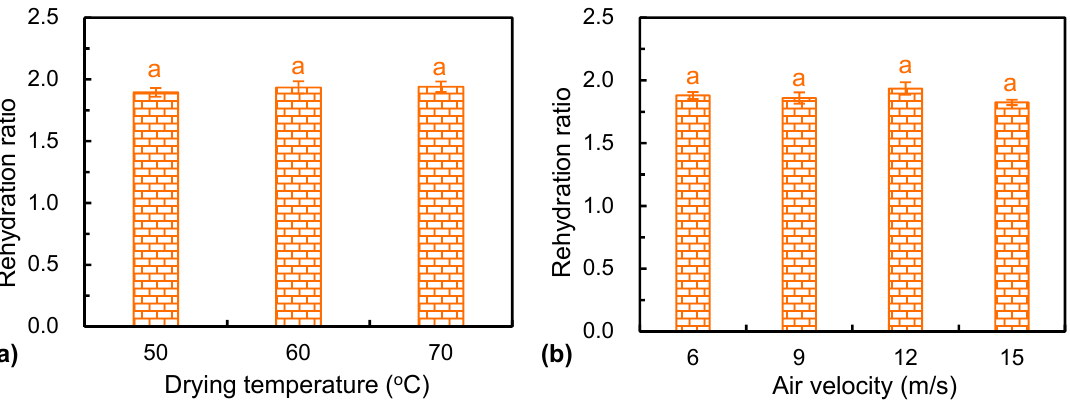
Figure 6. Rehydration ratio of dried Ophiopogonis Radix under different drying temperatures ( a ) and air velocities ( b ). The letter (a) indicates that there is no significant difference at p < 0.05.